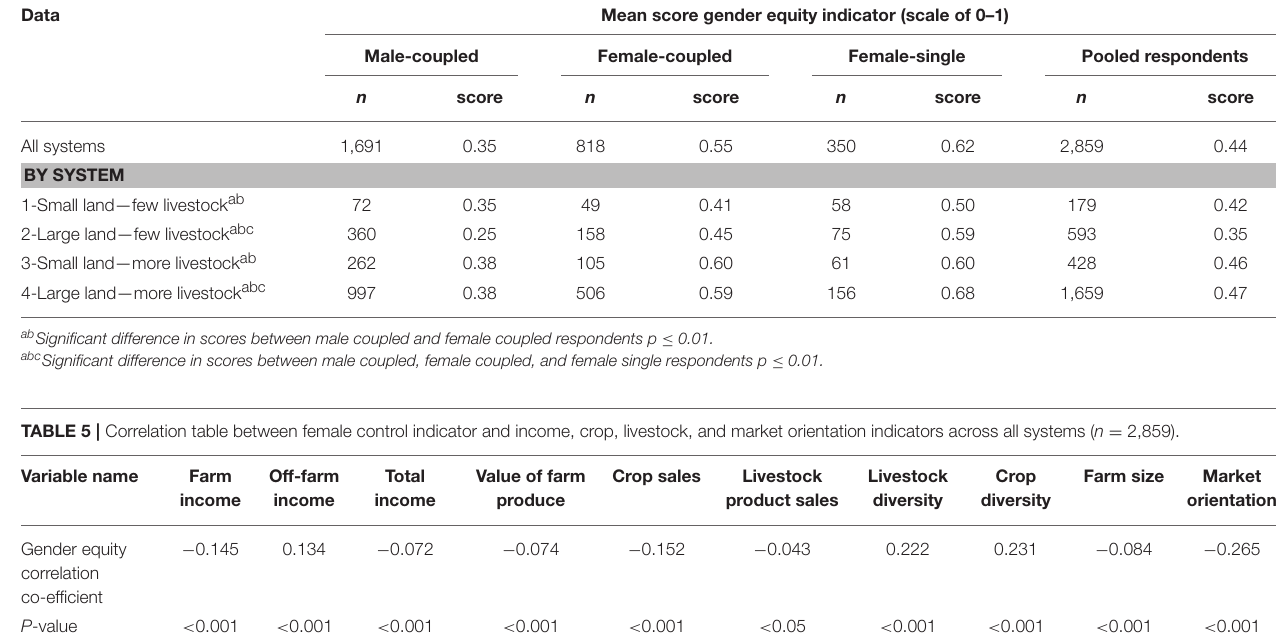
TABLE 4 | Mean scores for female control indicator by system type across respondent-household typologies.